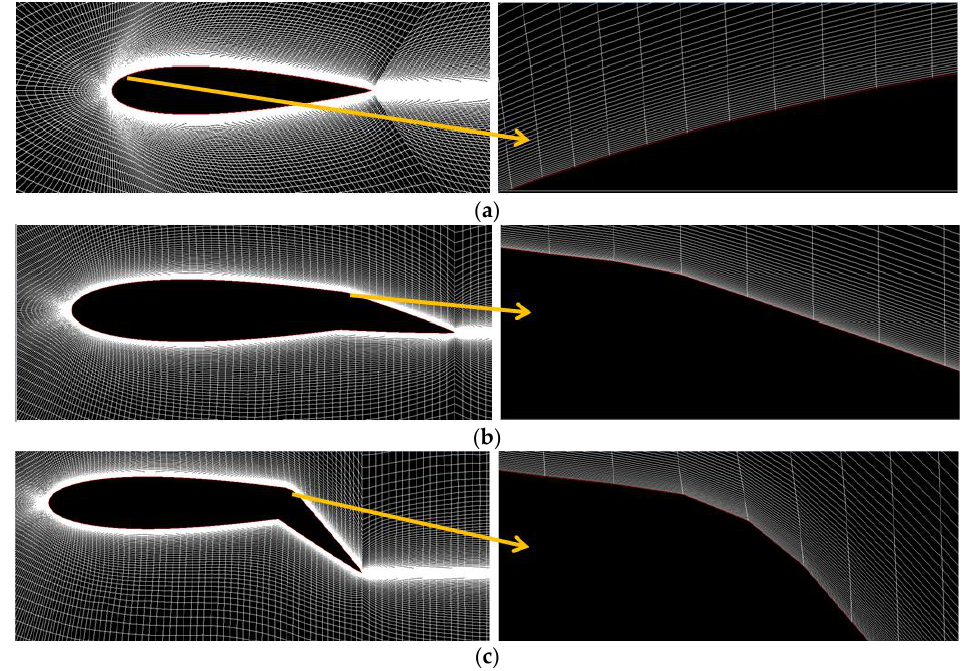
Figure 3. Mesh clustering toward airfoil surface and deflected flap regions. ( a ) Airfoil with 0° flap deflection; ( b ) airfoil with 10° flap deflection; ( c ) airfoil with 40° flap deflection.